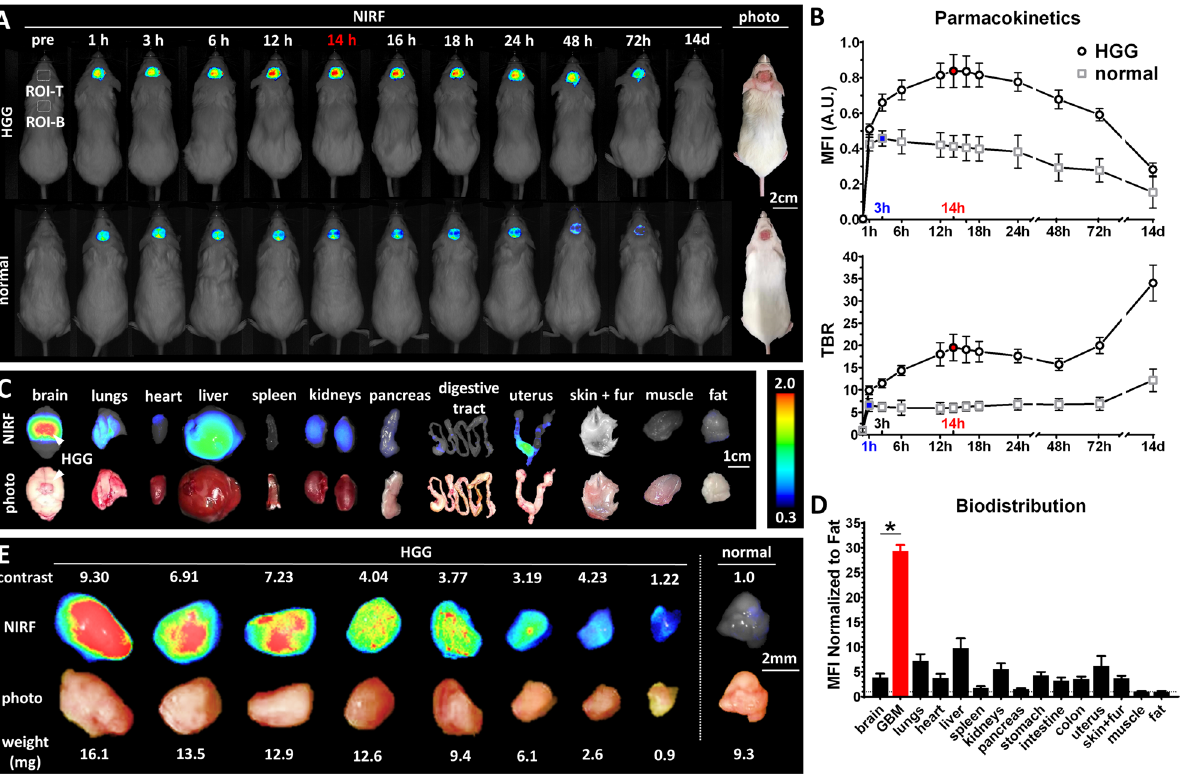
Figure 3. Pharmacokinetics and biodistribution of panitumumab-IRDye800 in vivo and ex vivo. ( A ) In vivo near-infrared fluorescence imaging (NIRF) of mice bearing orthotopic HGG xenografts or normal mice (sham injection of saline) with cranial windows before and after panitumumab-IRDye800 injection over the period of 14 days. Dotted boxes : regions of interest (ROI) for mean fluorescence intensity (MFI) and target-to-background ratio (TBR) measurements (T: tumor; B: background). ( B ) Pharmacokinetics of panitumumab-IRDye800 in normal and HGG bearing mice, with standard error of the mean. Red and blue : peak values and corresponding time points for HGG and normal mice, respectively. ( C ) NIRF images and corresponding photos of organs removed from HGG xenograft-bearing mice at 14 h post panitumumab-IRDye800 injection. Arrows : HGG xenograft. ( D ) Biodistribution in resected organs was quantified as MFIs (± SEM) normalized to that of fat, *P < 0.001 ( n = 5) between normal brain and HGG. ( E ) NIRF images and corresponding photos of serial bisected HGG tumor pieces and normal brain resected from mouse brains 14 h post panitumumab-IRDye800 injection. TBR: MFI of each HGG tissue piece divided by MFI of normal brain (TBR of normal brain is set to 1.0 for each